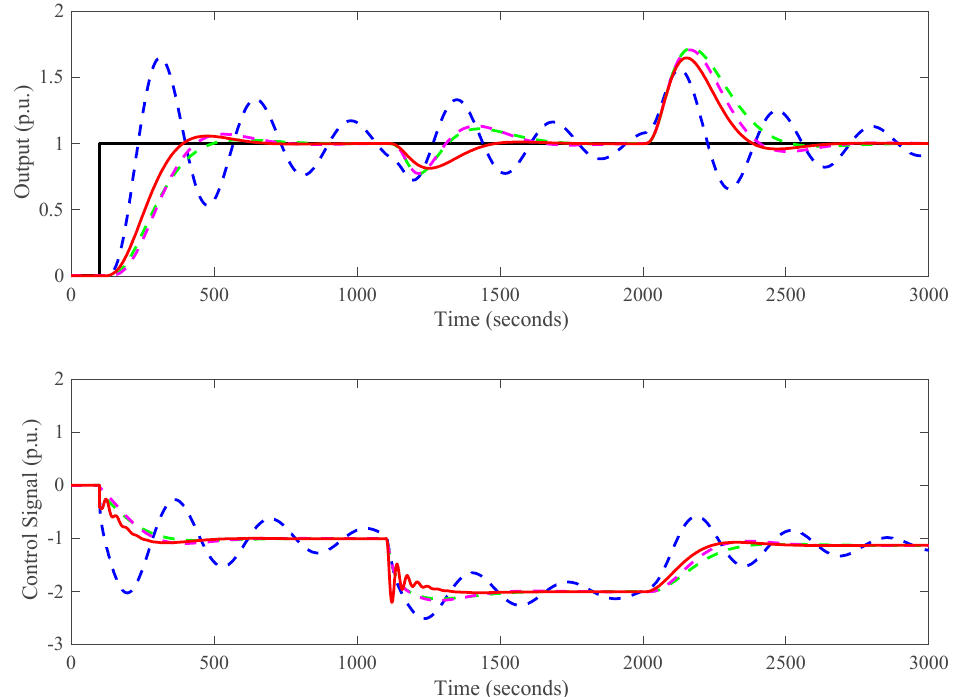
Table 4. Parameters of different control strategies for SST system in the simulator.